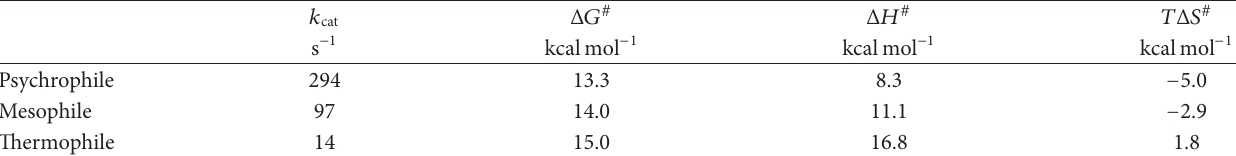
T 3: Activation parameters of the hydrolytic reaction of